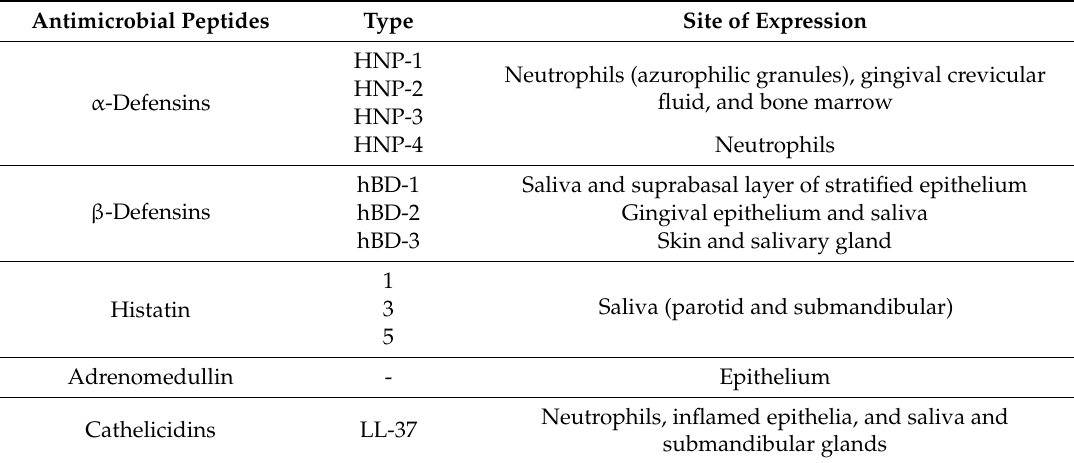
Table 3. List of key antimicrobial peptides (AMPs) present in the oral cavity